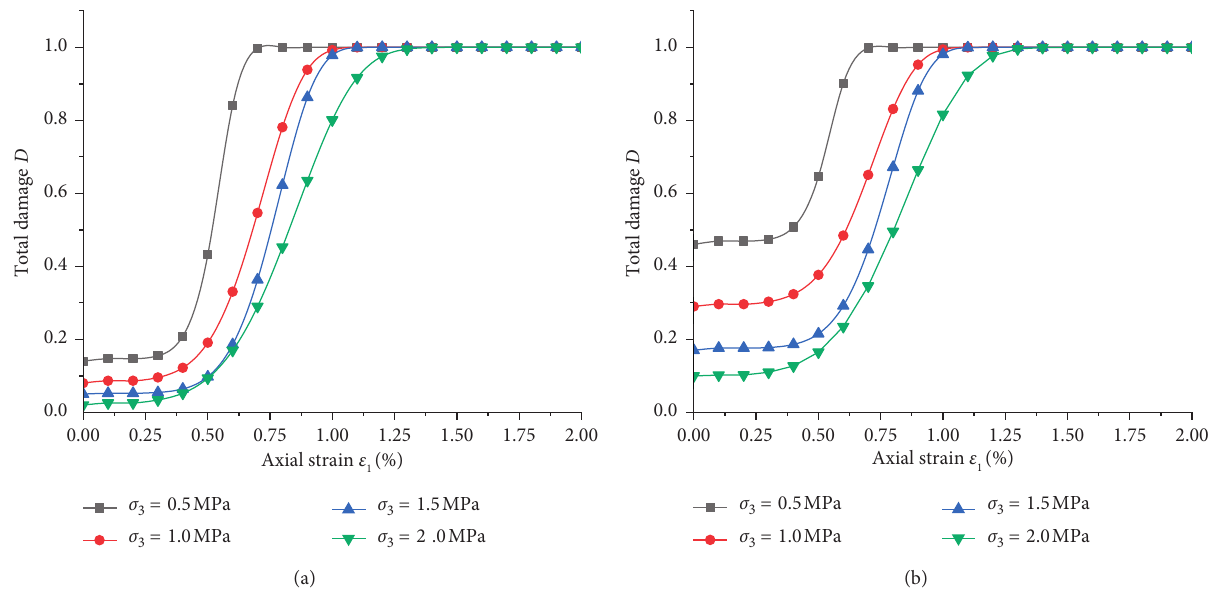
Figure 7: Damage evolution curves of backfill under different confining pressures. (a) Intact backfill. (b) Backfill with prefabricated